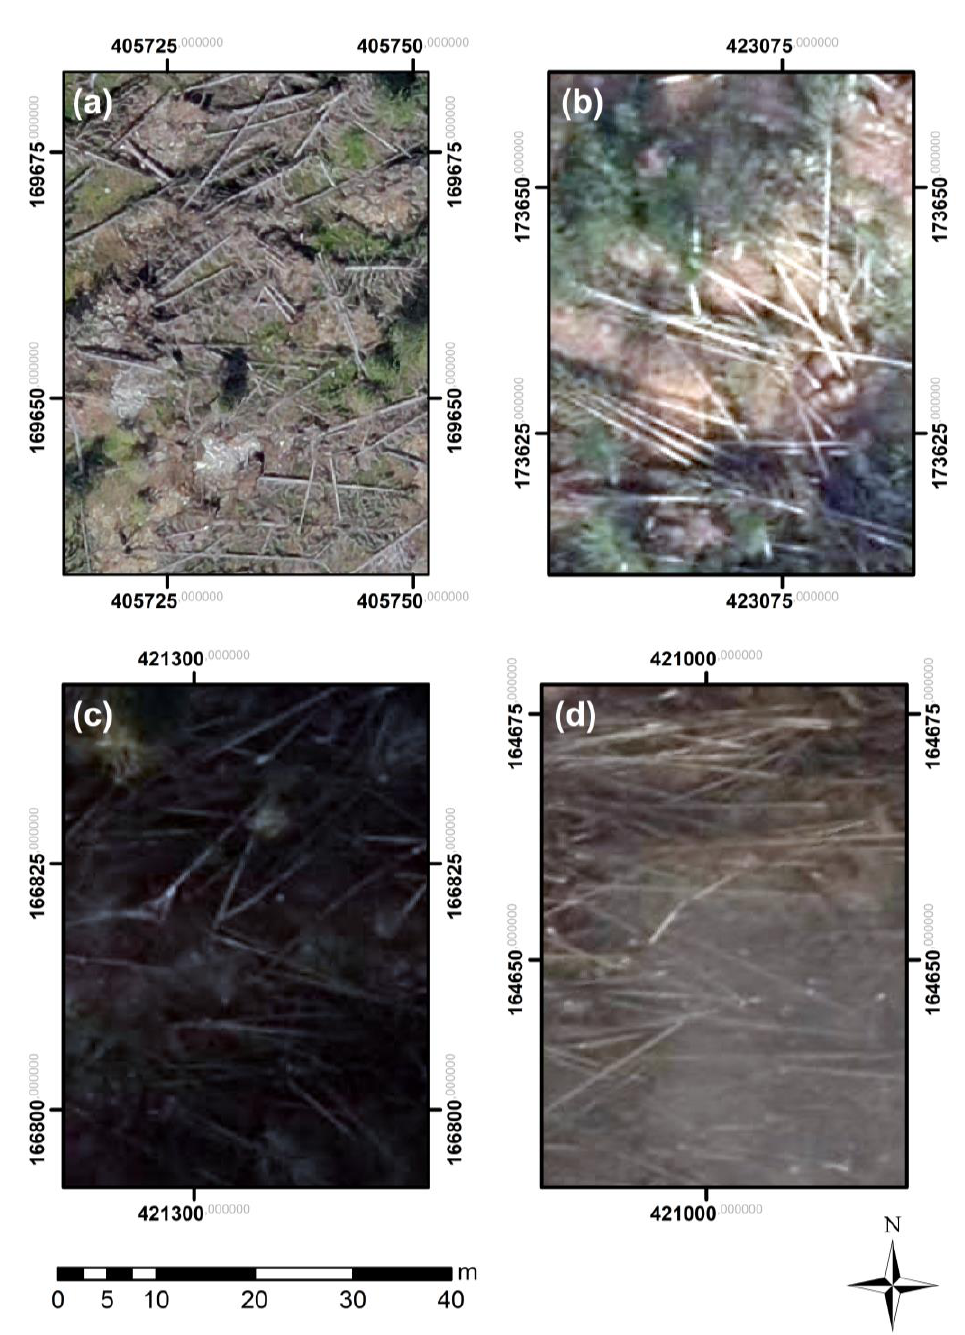
Figure 2. Exemplary aerial images with different ground sampling distance (GSD) and different quality; coordinates are in the “MGI/Austria GK M31” coordinate reference system (EPSG-code: 31258): ( a ) an optimal image, GSD = 11.84 cm; ( b ) an image with harsh shadows, GSD = 20.02 cm; ( c ) an underexposed image, GSD = 19.99 cm; and ( d ) an image with clouds and low contrast, GSD = 20.02 cm.